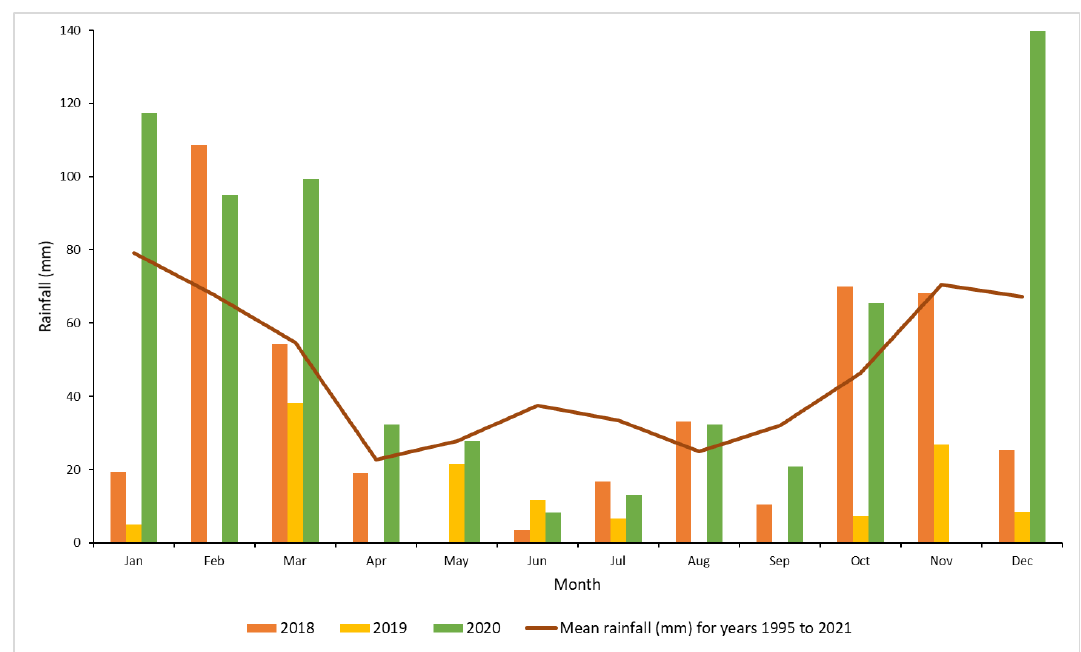
Figure 2. Monthly rainfall (mm) at Moree Airport for years 2018, 2019 and 2020 and the long term mean for Moree [28] .